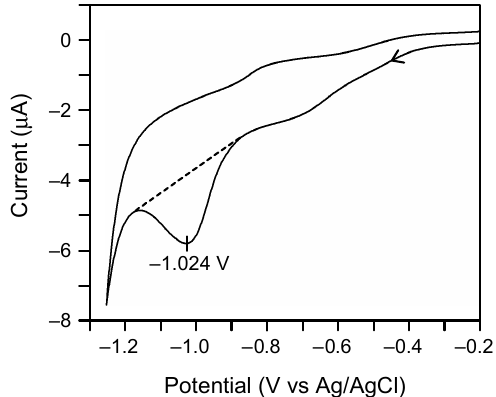
Figure 3. Reductive desorption of the SAM of 2b on Au(111), as observed by cyclic voltammetry using the surface-modified gold substrate as a working electrode in 0.5 M aqueous KOH. The scan rate was 0.02 V/s. The geometric area of the working electrode was 0.152 cm 2 . The charge for reductive desorption was calculated from the area below the dotted line. Table 1. Peak potential ( E p ), charge density ( Q red ), and full width at half-maximum ( ∆ E fwhm ) for the electrochemical reductive desorption of SAMs derived from trithiols and dodecanethiol on Au(111). a E Thiol